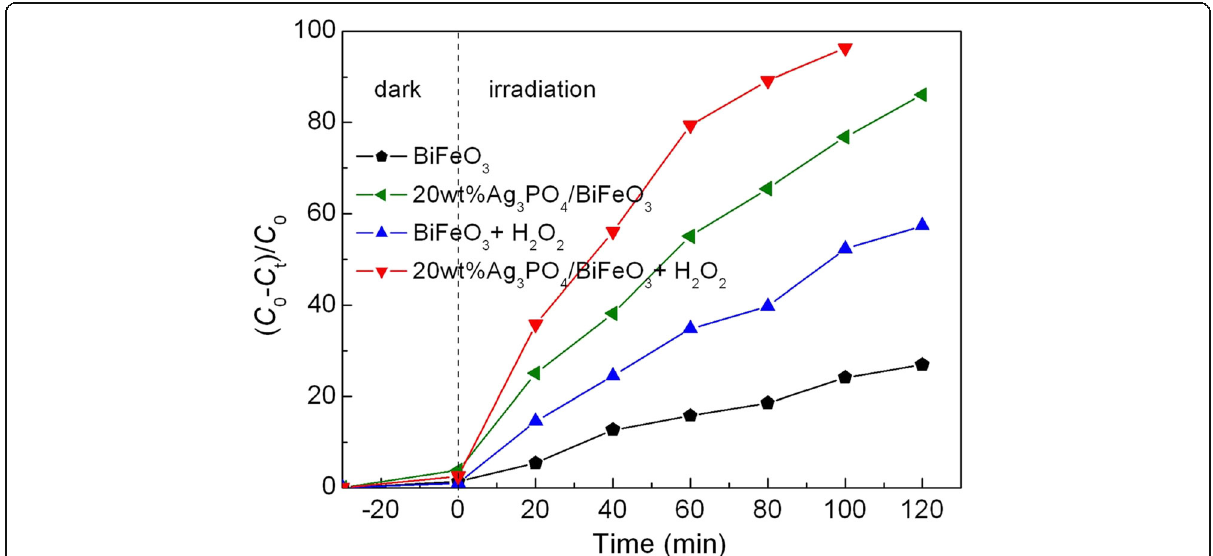
Fig. 9 Photocatalytic activities of BiFeO 3 and 20wt%Ag 3 PO 4 /BiFeO 3 sample toward the degradation of AO7 under visible-light irradiation in the presence of H